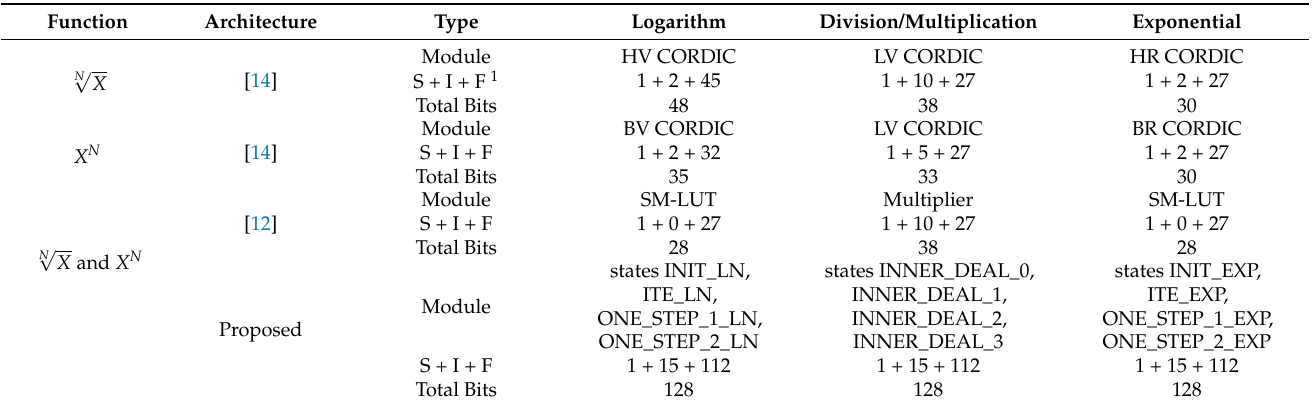
Table 5. Word length for [12,14] and the proposed